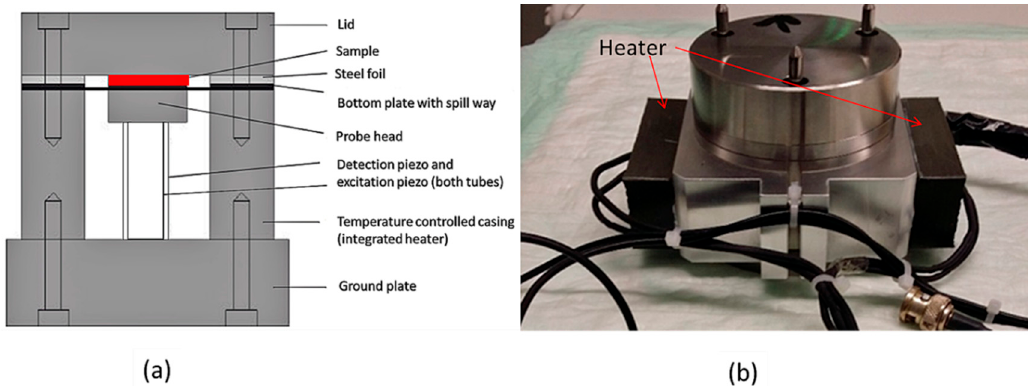
Figure 1. ( a ) Schematic drawing of the optimized PIEZ system (modified after Kirschenmann) [17]. The system consists of a bottom plate and a lid, which hermetically closes the system. The bottom plate is moved by an excitation piezo (inner tube), and the sample is squeezed. The damping of the sample depends on the viscosity of the sample and can be detected by the detection piezo (outer tube). A steel foil creates the measuring gap between the bottom plate and lid. ( b ) Picture of the PIEZ with an integrated heater (indicated by arrows).